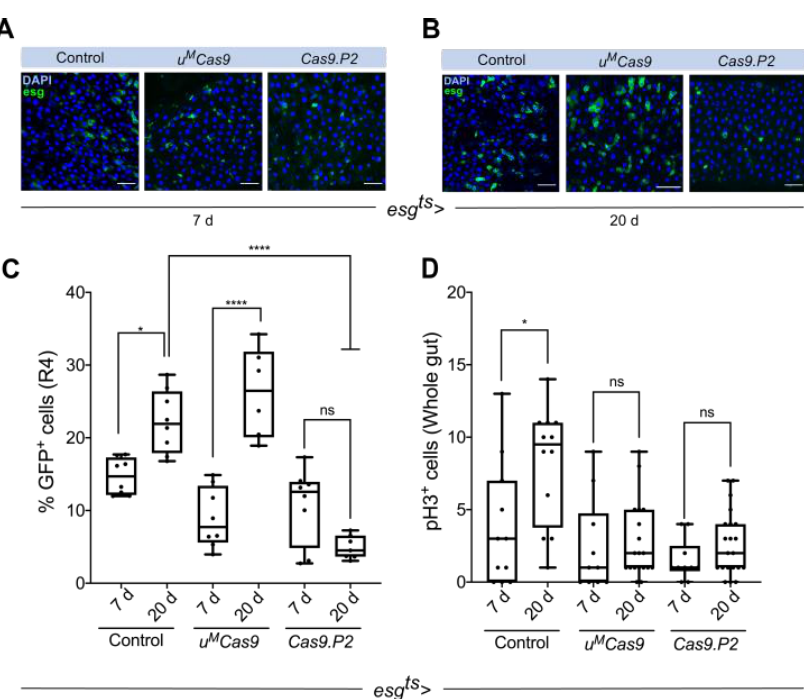
Figure 2. Continuous expression of Cas9.P2 is deleterious to ISCs/EBs. ( A ) ISCs/EBs in control animals displayed an age-dependent increase in their numbers (A; 7 days, B; 20 days, see quantifications in panel C). ( B ) Continuous expression of Cas9.P2 , but not u M Cas9 , for 20 days noticeably reduced ISCs/EBs. ( C ) Quantifications of ISCs/EBs numbers at seven days and 20 days in animals either expressing no Cas9 , u M Cas9 , or Cas9.P2 . Notice that in both the control animals and those expressing u M Cas9 , ISCs/EBs significantly increased from seven days to 20 days. ( D ) The number of mitotic cells increased in the whole gut of the control animals from seven days to 20 days, but this could not be seen in animals continuously expressing Cas9.P2 at these timepoints. Scale bar: 30 µ m. * p < 0.05, **** p <